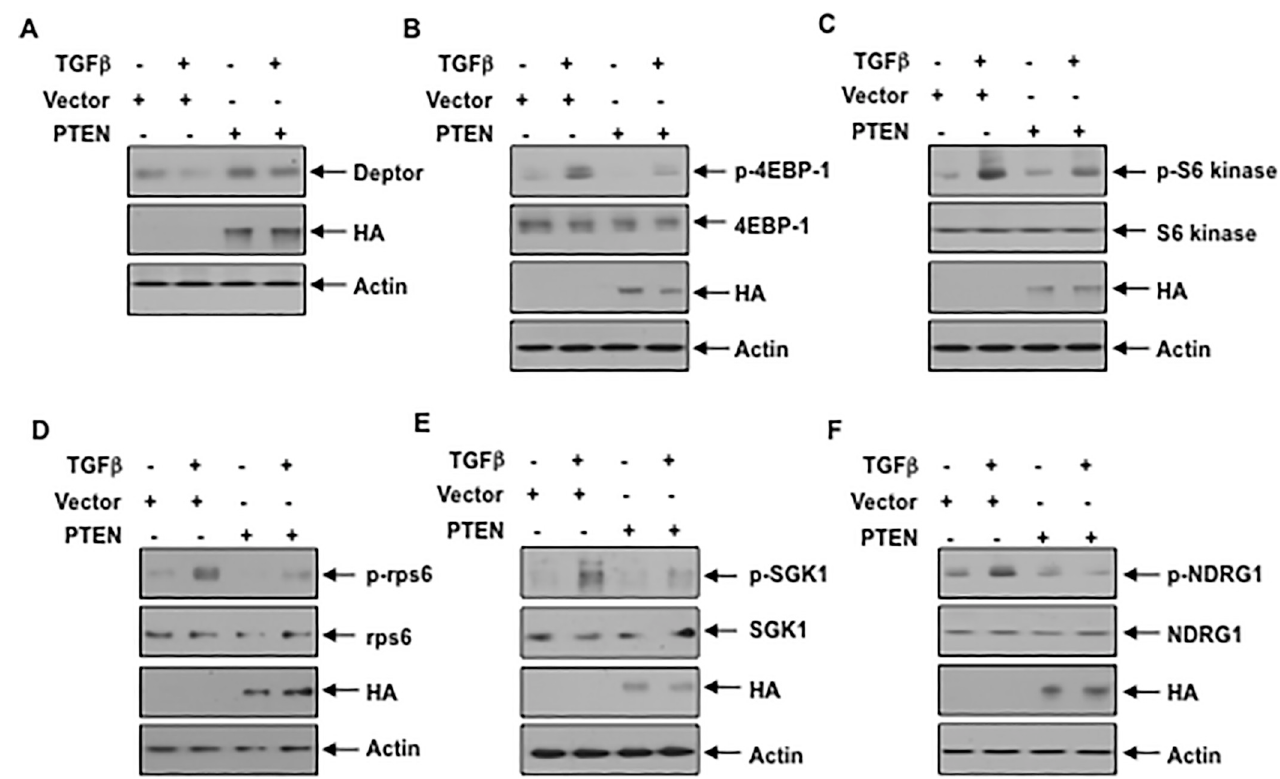
Fig 3. Expression of PTEN prevents TGF β mediated downregulation of deptor and mTORC1 and mTORC2 activities. Podocytes were transfected with the HA-tagged PTEN expression plasmid. The transfected cells were serum starved and incubated with TGF β The cell lysates were immunoblotted with the indicated antibodies. Representative blots from four independent experiments are shown in each panel. The quantification is shown in the S4 Fig.